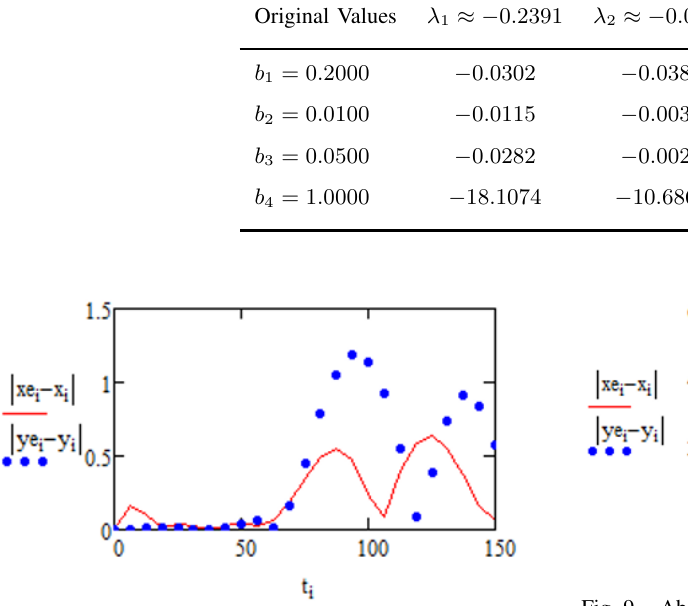
Fig. 9. Absolute errors of calculation for N +1 = 25 points (Integration